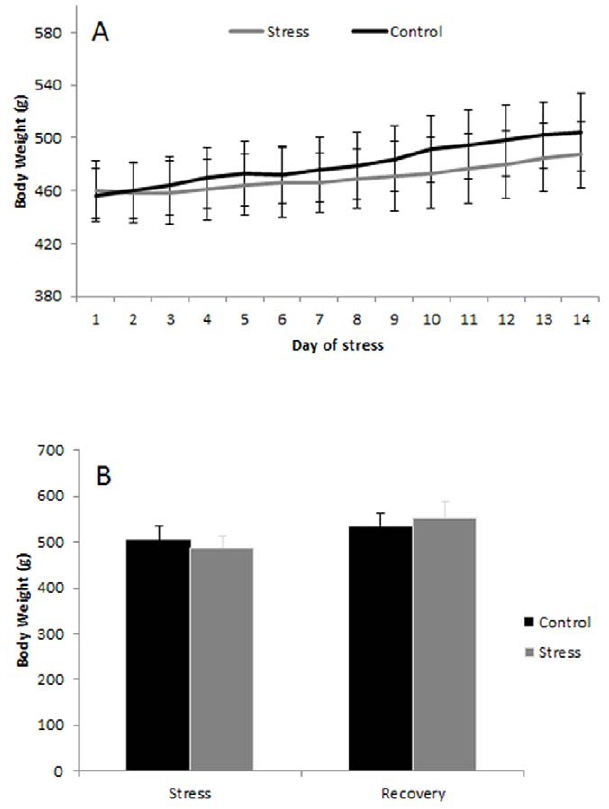
Figure 1. A: Body weight growth curves. The time course of body weight gain in animals undergoing two weeks of stress (gray) and non- stress control animals (black). Note that stress moderately diminished the average rate of weight gain (mean 6 SD). B: Body weight (means 6 SD) after two weeks of stress (‘‘Stress’’) and after two weeks of stress followed by two weeks of recovery (‘‘Recovery’’).